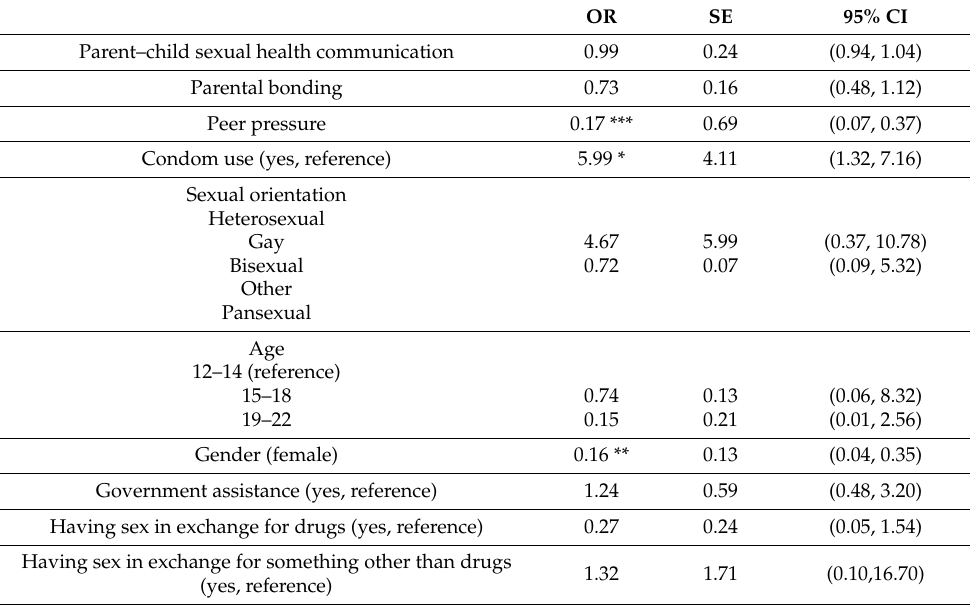
Table 5. Multivariable analysis sex on drugs/alcohol ( N =